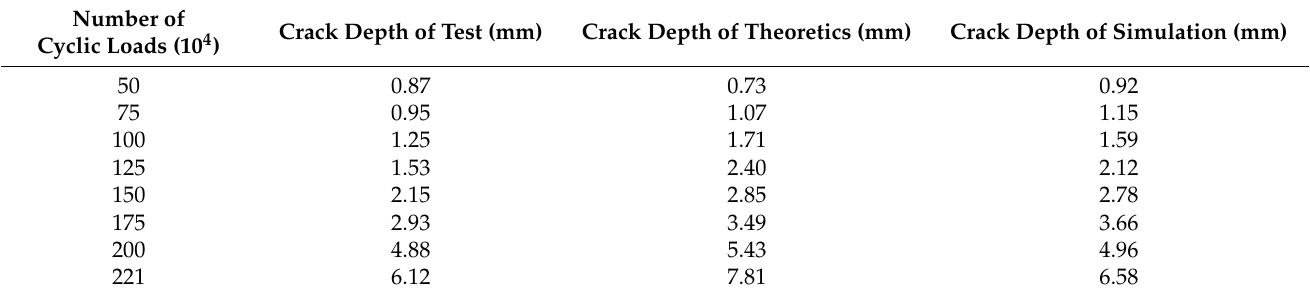
Figure 24. Crack patterns of studs under different numbers of cyclic loads: ( a ) N = 500,000; ( b ) N = 750,000; ( c ) N = 1,000,000; ( d ) N = 1,250,000; ( e ) N = 1,500,000; ( f ) N = 1,750,000; ( g ) N = 2,000,000; ( h ) N = 2,210,000. Table 9. Comparison of FEA results with the test and theoretical calculation results.